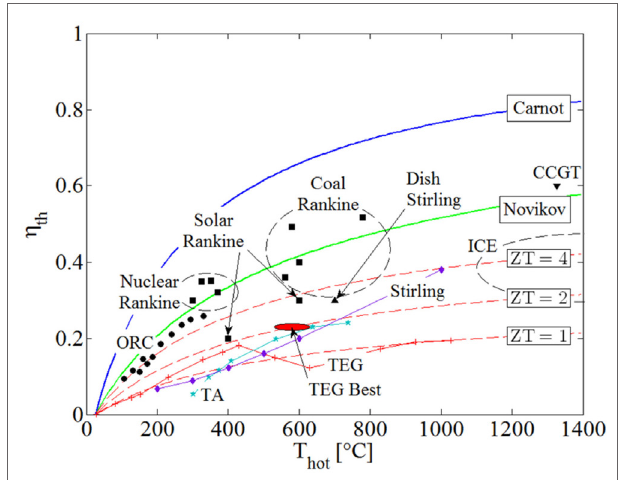
FiGURe 1 | Thermal efficiency, η th , of common thermodynamic heat engines and TeGs over a range of heat-source temperatures, T hot . The circles represent actual ORC and Kalina cycles’ applications; squares are for various Rankine cycles; triangles for solar dish Stirling and CCGT cycles; diamonds for conventional Stirling; and stars for TA engines. The solid red line represents the current performance of TEGs, with the three dashed red lines indicating TEG figure-of-merits ZT = 1, 2, and